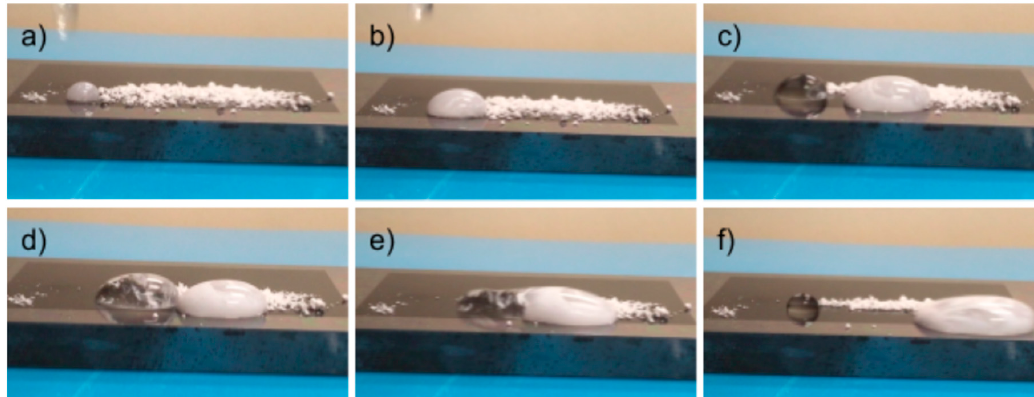
Figure 8. A series of frames of water droplets cleaning aluminum oxide powder on the hydrophobic metal surface over a time interval of 8 seconds. ( a ) First water droplet makes contact with the powder and hydrophobic region of the metal. ( b – e ) As droplets move down the surface, the powder on the metal is collected. ( f ) The water droplet with the powder rolls o ff the processed area.